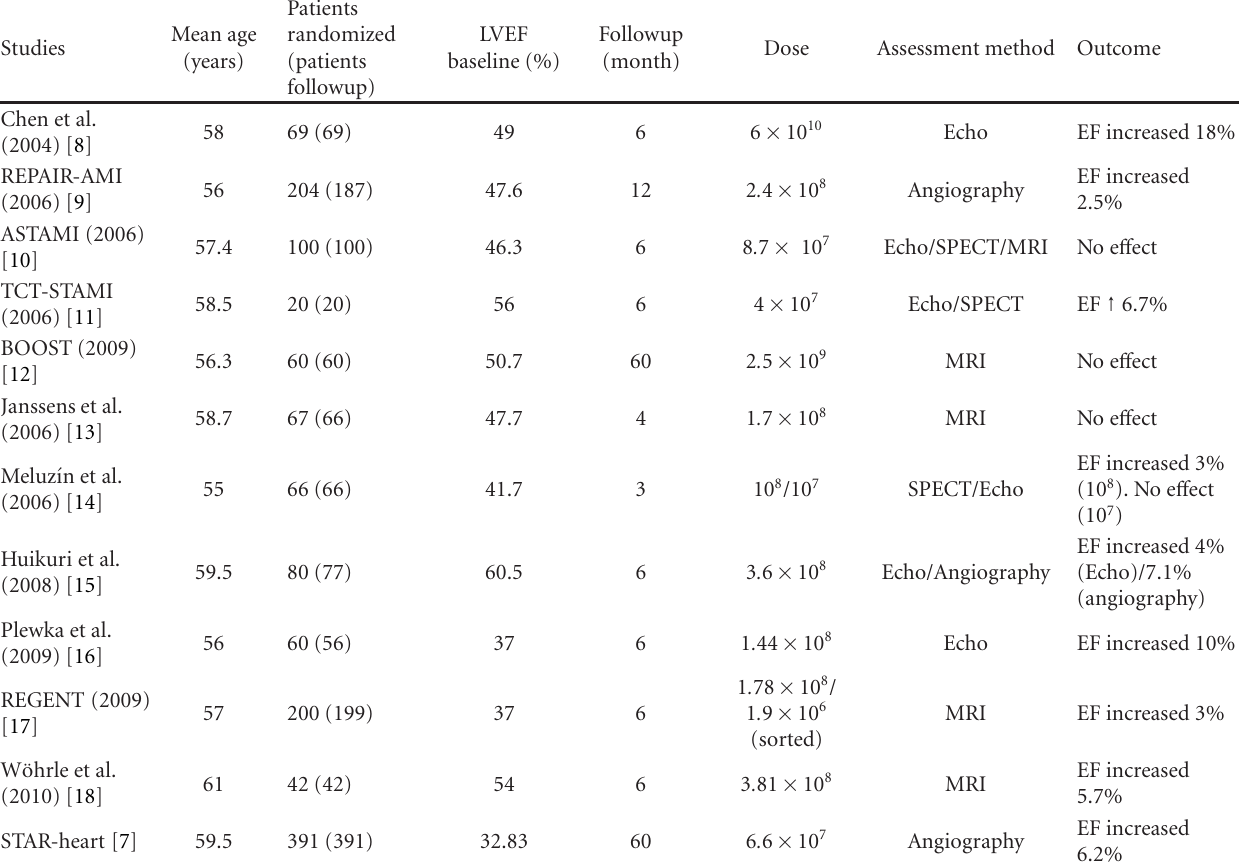
Table 1: Randomized controlled bone marrow-derived cell trials in myocardial